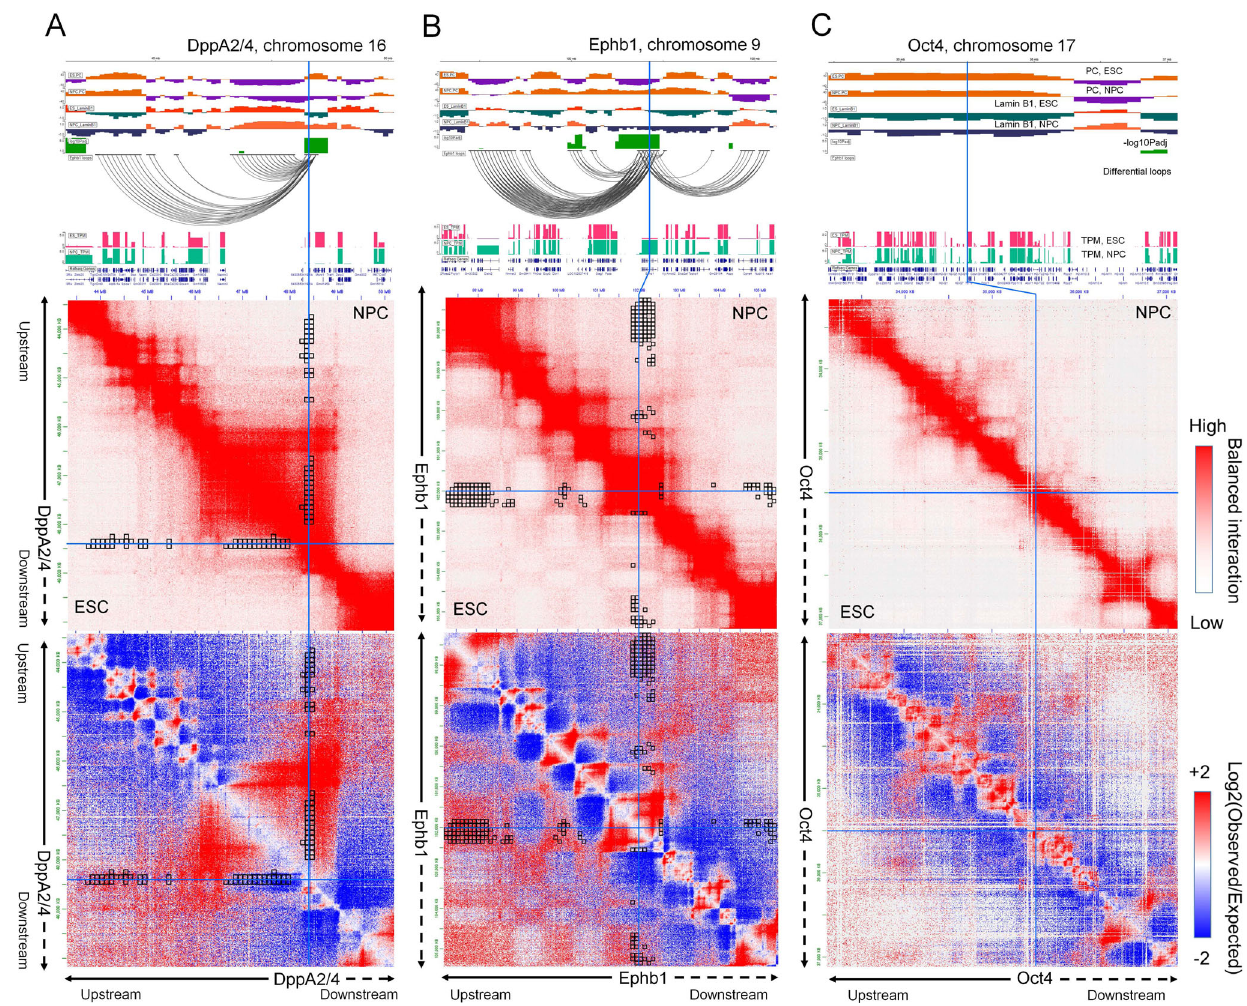
Fig. 4 | Differences in local chromatin interactions of differential compart- ments. Detailed browser views (top), Hi-C contact maps (mid) and differential chromatin interactions (bottom) of three gene loci – A DppA2/4 , B Epbh1 , and C Oct4 .Visiblechangesininteractionsinvolvingthe Dppa2/4 locusand Ephb1